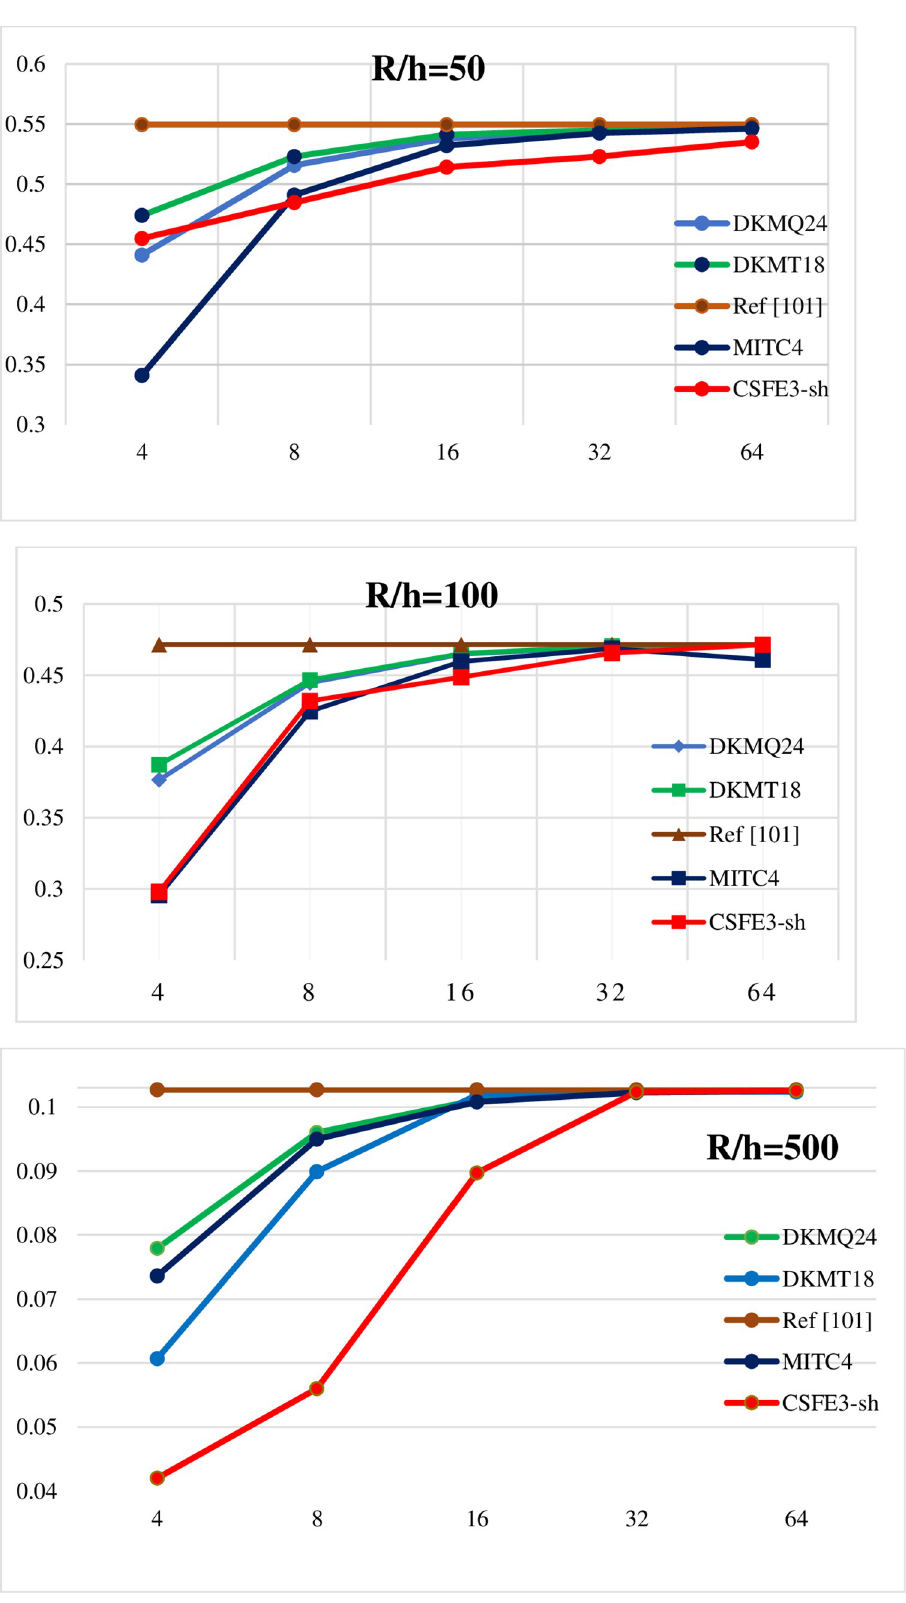
Fig 13. Charts of defection convergence at point C (R/h = 50, R/h = 100 et R/h = 500). https://doi.org/10.1371/journal.pone.0267480.g013 PLOS ONE | https://doi.org/10.1371/journal.pone.0267480 May 13,